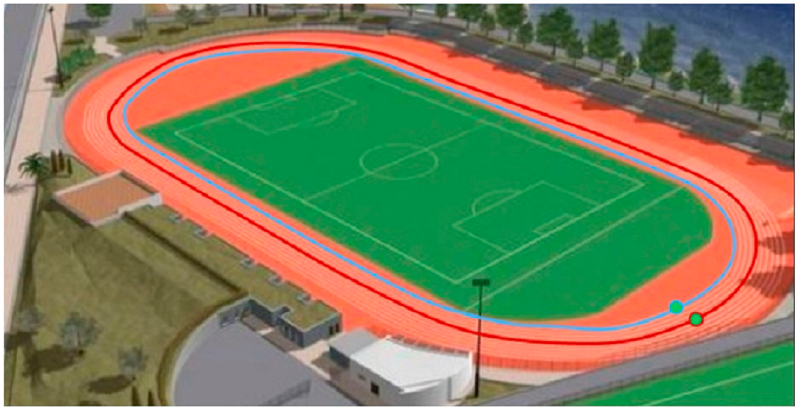
Figure 1. Example of system fixed infrastructure positioning in a stadium. Two concentric loops have the size of a standard athletic lane. Each loop is fed with different currents to identify the left and right side .